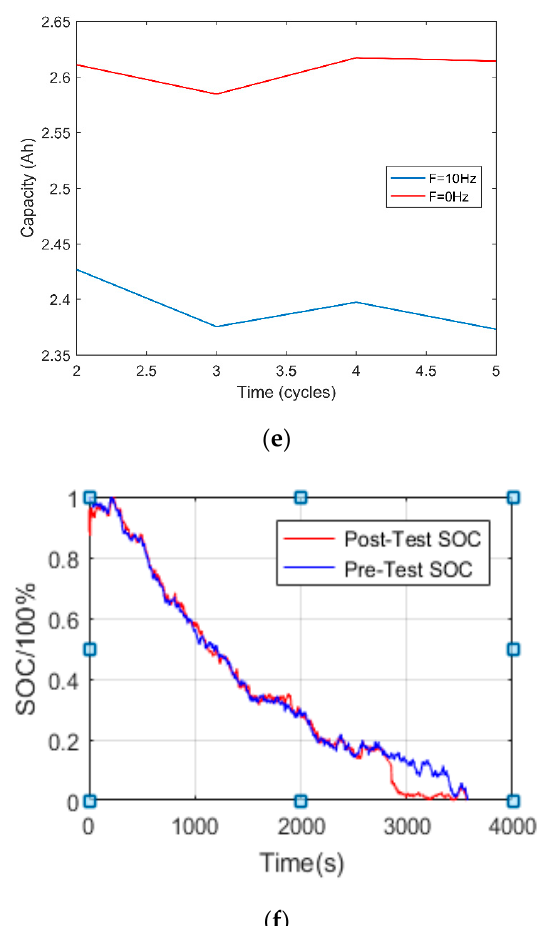
Figure 10. Discharge trajectories of battery cells: ( a ) discharge with no vibration in battery cell 5–8, ( b ) discharge voltage-current vs. time, ( c ) discharge-voltage before and after vibration, ( d ) discharge- capacity before and after vibration, ( e ) discharge capacity before vibration (0 Hz) and after vibration (f = 10 Hz), and ( f ) pre-test and post-test battery SOC.